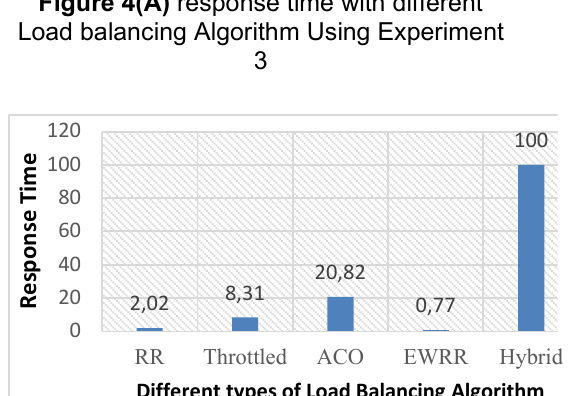
Figure 4(A) response time with different Load balancing Algorithm Using Experiment